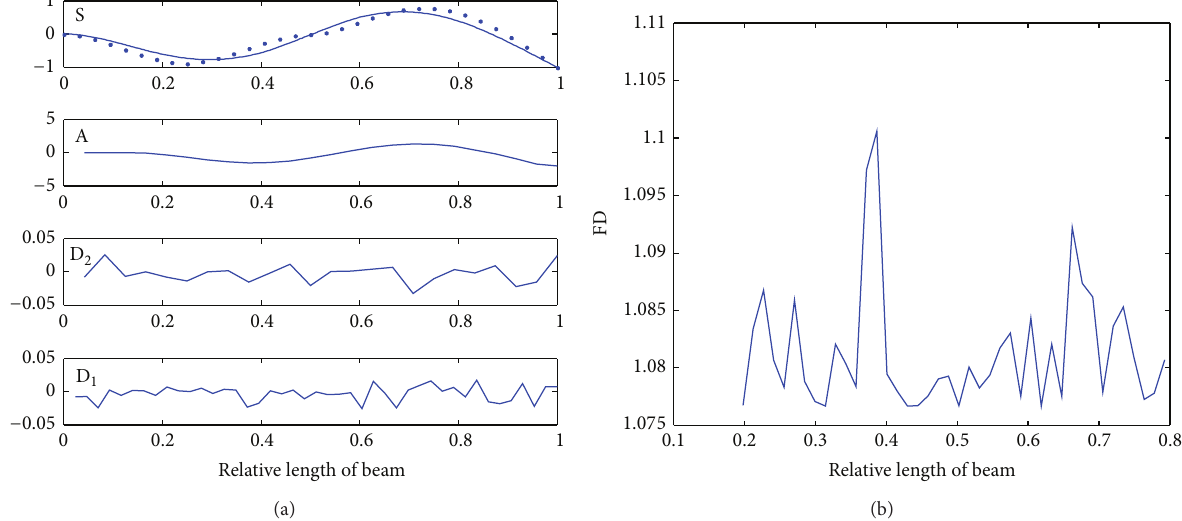
Figure 11: Crack location identification results in experimental circumstances. (a) The third measured mode shape S and its wavelet decomposition at level 2. (b) FD of the detailed signal D 1